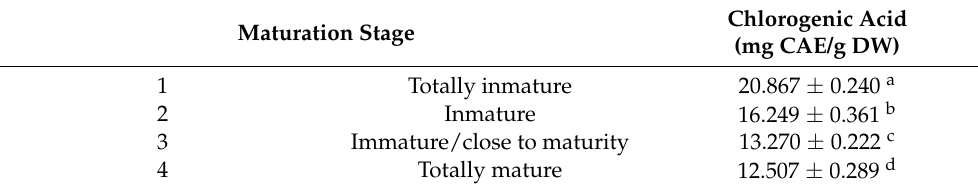
Figure 2. HPTLC chromatogram performed for the identification and quantification of chlorogenic acid from Vaccinium stenophyllum Steud. fruit extracts, taken under UV light (366 nm) after derivatization with NP reagent. The mobile phase was a mixture of ethyl acetate (10): formic acid (1.1): acetic acid (1.1): water (2.3) ( v / v / v / v ). Chlorogenic acid was applied on different volumes as a 4-point calibrated (3, 6, 9 and 12 µL, equivalent to 0.3, 0.6, 0.9 and 1.2 µg; y = 2.745 × 10 − 4 x − 5.225 × 10 − 2 , R 2 = 0.9900). Vaccinium stenophyllum Steud. fruit extract (stages 1–4) were applied in triplicate, volume = 2 µL (20 mg DW/mL). Table 4. Quantification of chlorogenic acid by HPTLC in methanolic extracts of Vaccinium stenophyllum Steud. fruits during ripening.